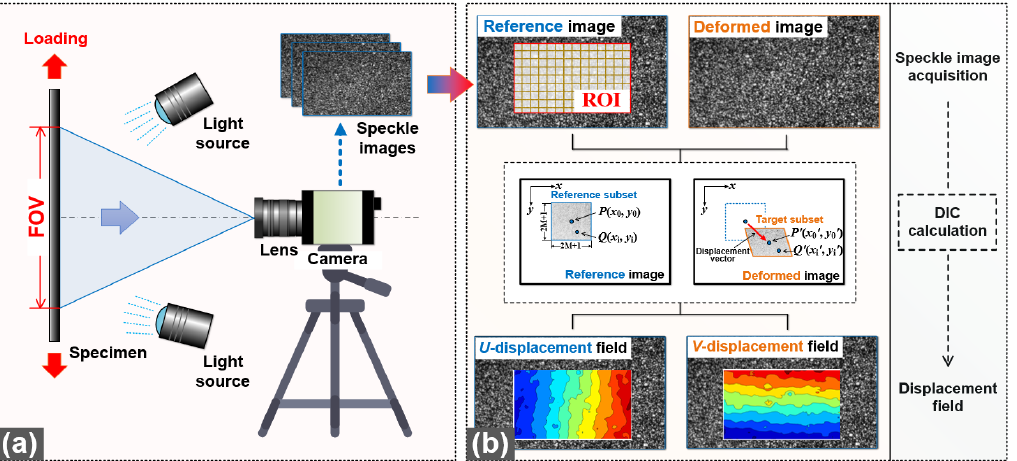
Figure 1. Two-dimensional digital image correlation: ( a ) system configuration, ( b ) in-plane displacement field calculation.